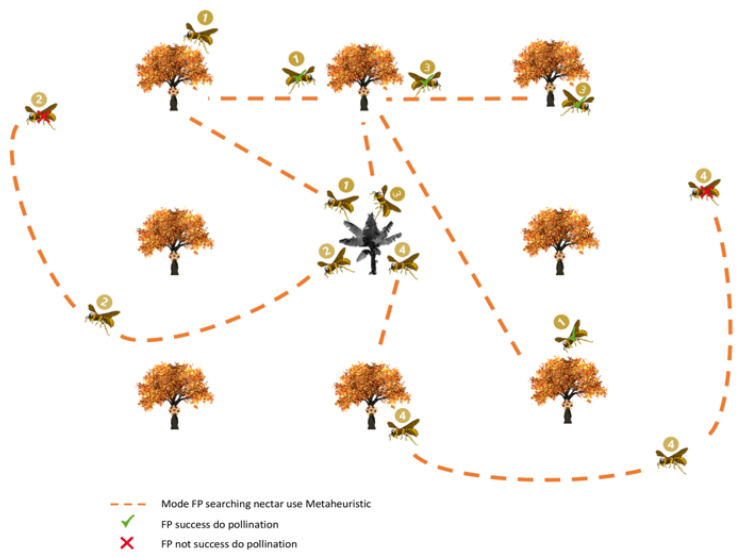
Figure 1. Process flow of Forcipomyia